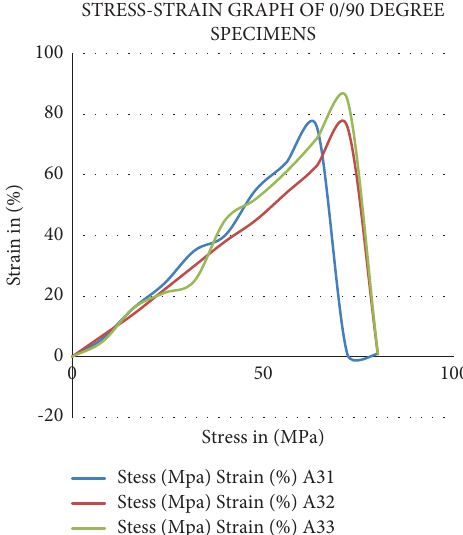
Figure 10: Stress–strain graph of 0 ° /90 °